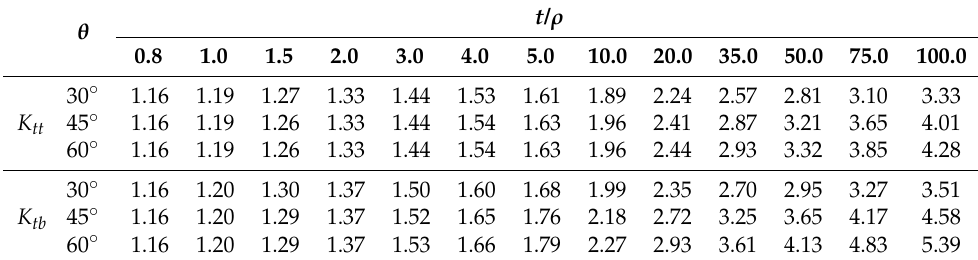
Table 8. Influence of the weld angle θ and t / ρ ratio on SCF for L > 4 t .